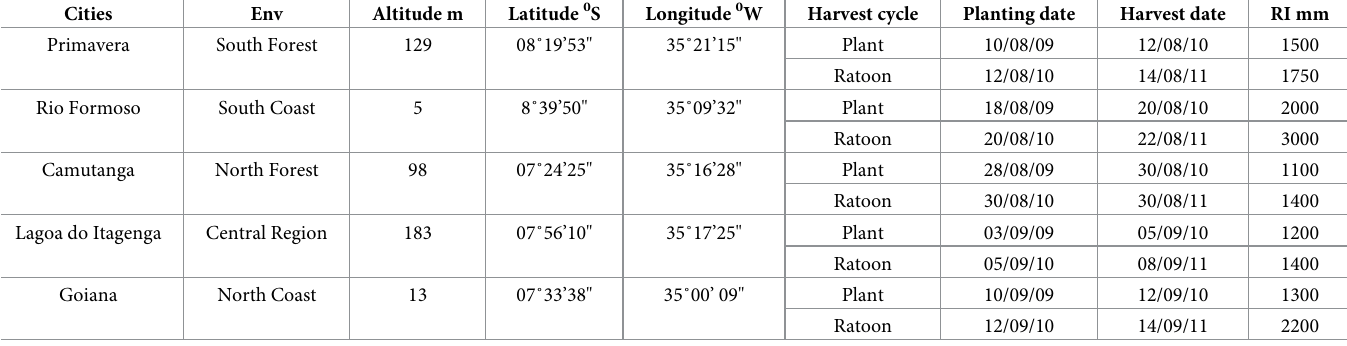
Table 1. Environment description, geographical coordinates of assessed locations, and general data on experimental conditions.